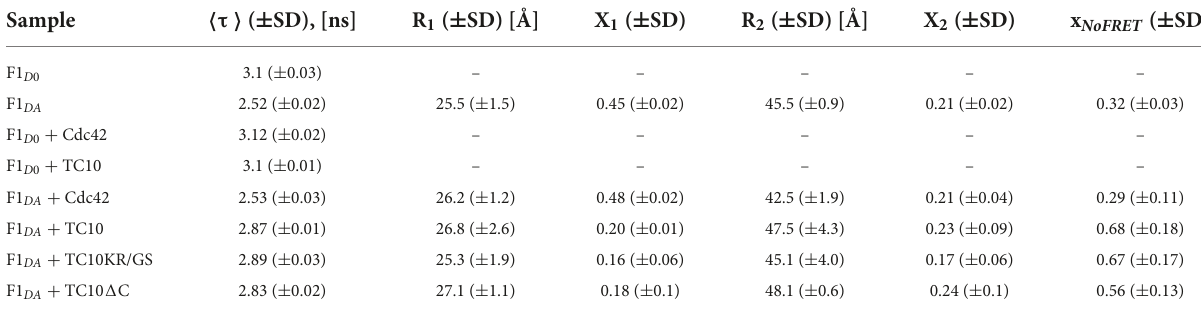
TABLE 1 Table representing the species-weighted average fluorescence lifetime ( (cid:104) τ (cid:105) ) and inter-fluorophore distances (R i ) along with their relative species fractions (x i ) obtained from time-resolved FRET analysis for the CB-FRET sensors (F1 D 0 and F1 DA ) alone and after incubation with a 100-fold molar excess (100 µ M) of Cdc42, TC10, and its C-terminal variants. Sample